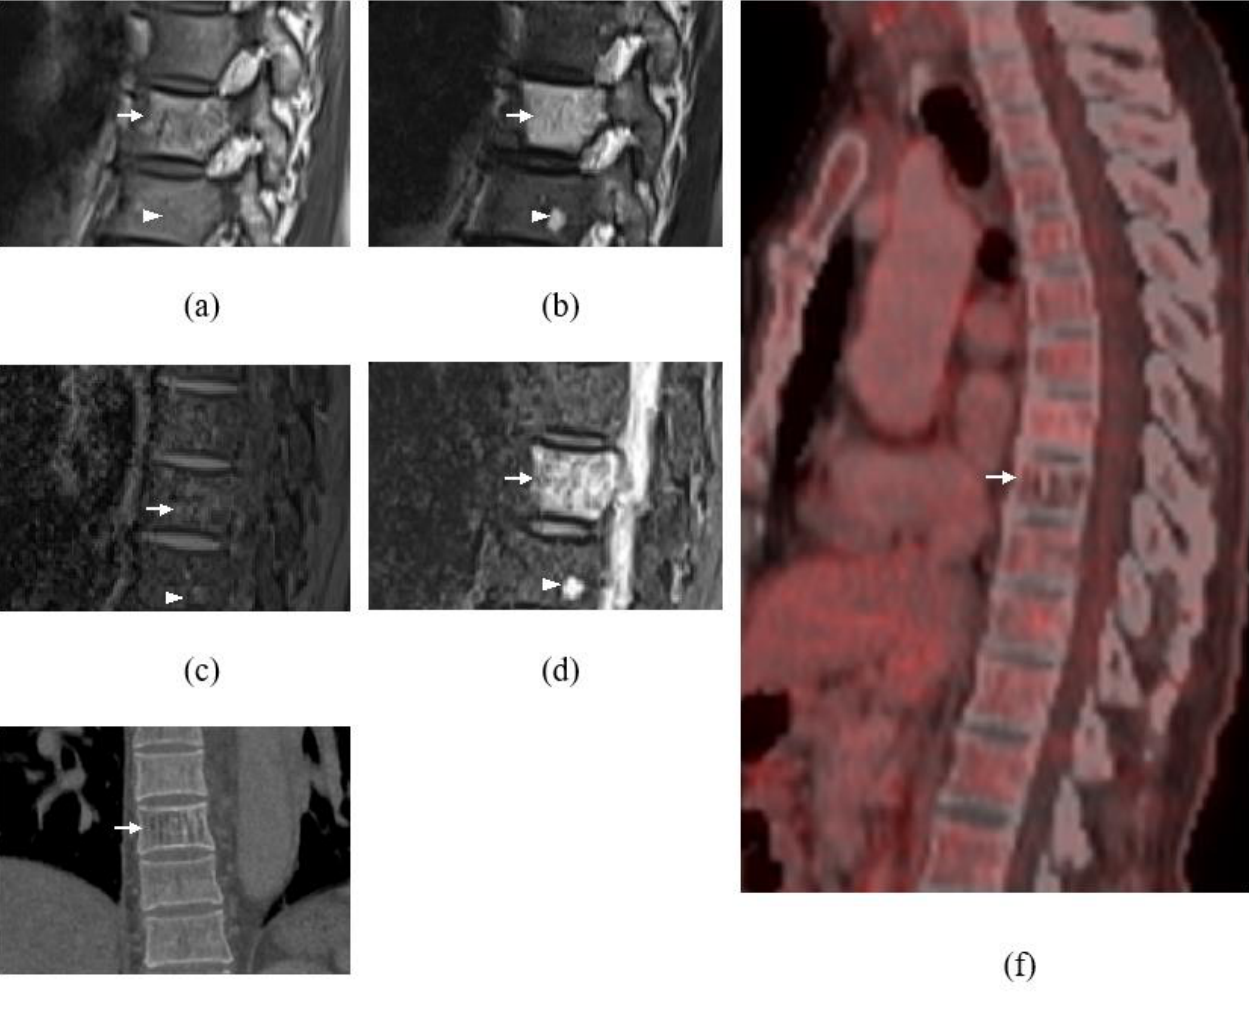
Figure 3. Sagittal images ( a – d ) at T8 to T10 level showing lesion (white arrow) at T9 vertebral body demonstrating hyperintense signal on T1WI ( a ) and T2WI ( b ) with signal suppression on fat saturation sequence ( c ) and minimal enhancement on post contrast sequence ( d ), typical of hemangioma. Coronal bone algorithm CT shows classic corduroy sign in hemangioma at T9 vertebral body ( e ). Sagittal plane of thoracolumbar spine (f) of 18 F-FDG PET/CT also showed reduced FDG metabolism of the T9 lesion (white arrow) with no FDG avid lesion seen at the thoracolumbar spine to suggest metastasis. Another small lesion (arrowhead) at T10 vertebral body which is isointense on T1WI ( a ), hyperintense on T2WI ( b ) with enhancement on post contrast sequence ( d ).